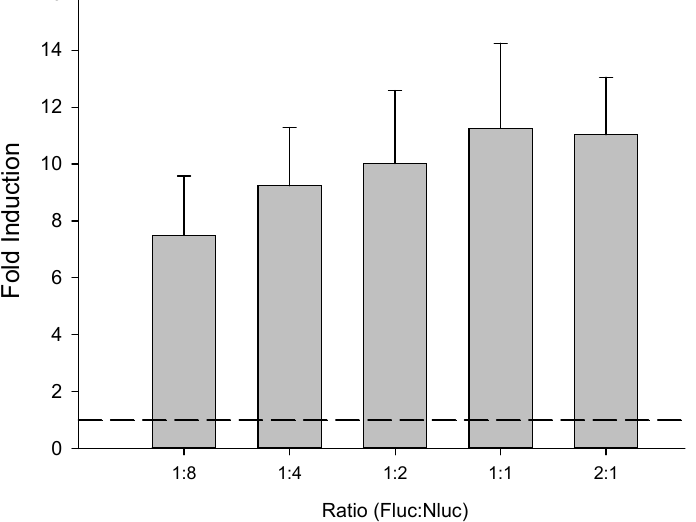
Figure 2. Transactivation activity (fold induction) values observed on cells transfected with different proportions of mpFN26A[Fluc/PPAR γ ] and mpGL4.35[Nluc] vectors, challenged with 10 µM rosiglitazone. The basal response to the control (DMSO) is represented by the dashed line (y = 1). Data are shown as mean ± standard error of the mean (SEM) of four assays performed independently (n = 4). DMSO concentration did not exceed 0.1% per well.